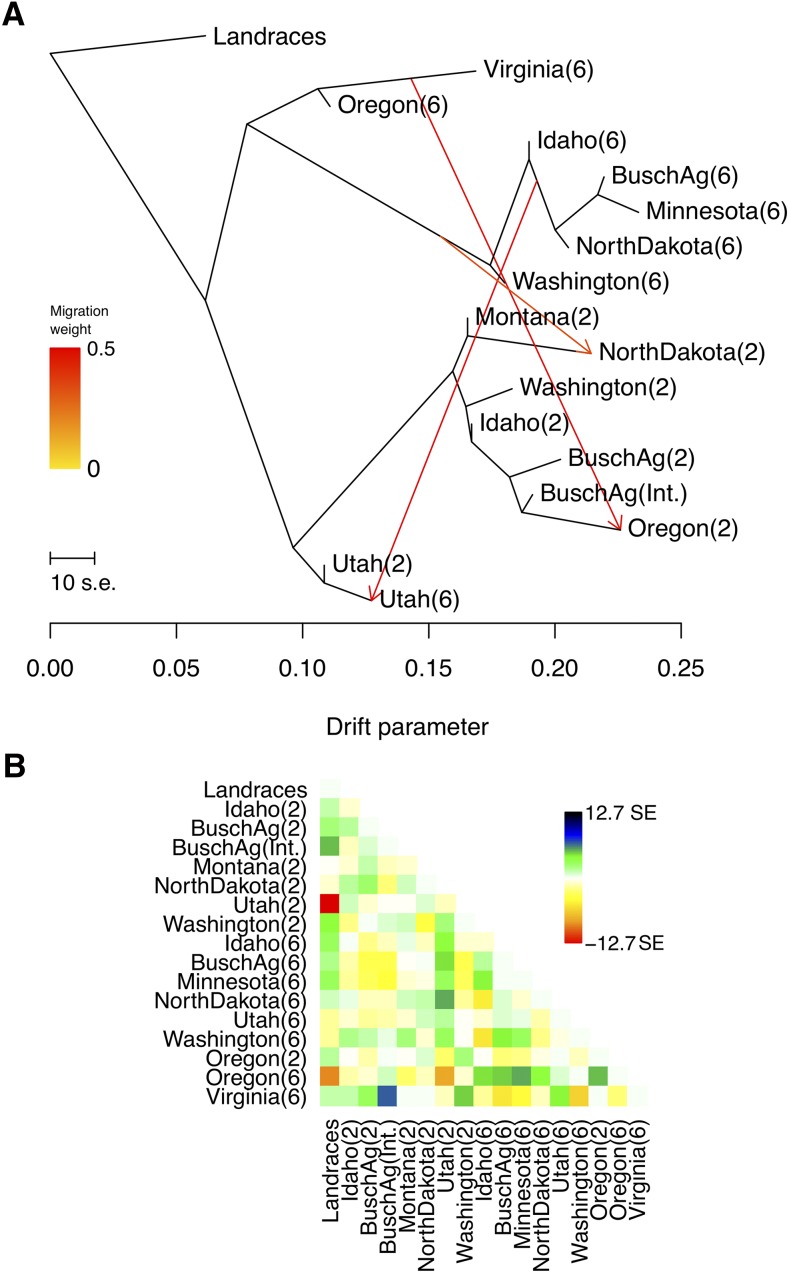
Tree of relatedness among North American breeding populations. (A) Plotted is the structure of the graph inferred by TreeMix for the 16 North American breeding populations, allowing three migration events. The arrows (migration events) are colored according to their weight. Horizontal branch length is proportional to the amount of genetic drift in the branch. The scale bar on the left shows 10 times the average standard error of the entries in the sample covariance matrix. (B) Residual fit of inferred tree of relatedness. Residuals above zero represent populations that are more closely related to each other in the data than in the best-fit tree, thus are considered candidates for admixture events. Spike-type for each population is shown in parentheses.